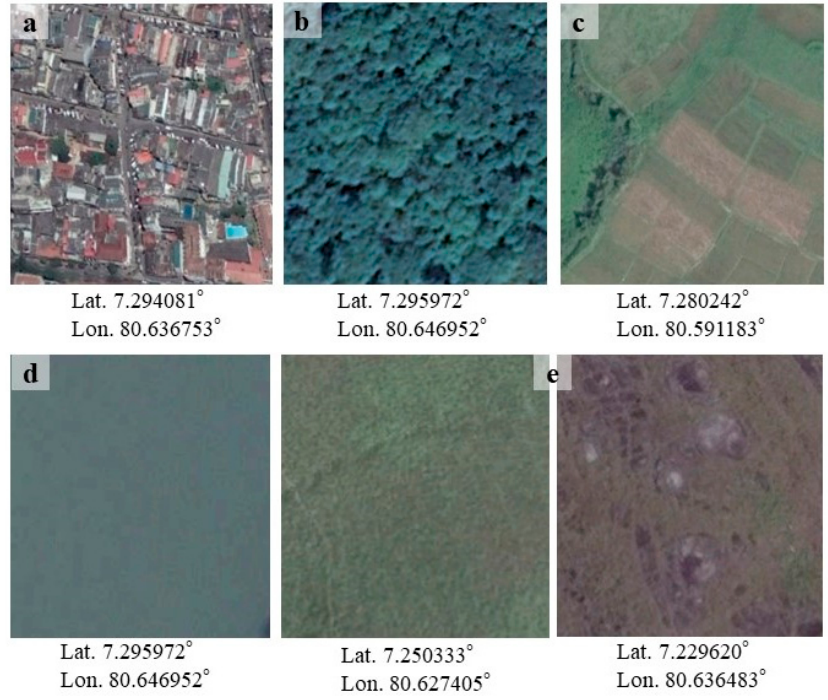
Figure 2. Land-use / land-cover (LULC) sample images with location information: ( a ) impervious surface (IS), ( b ) forest cover (FC), ( c ) cropland (CL), ( d ) waterbody (WB), and ( e ) other land (OL).